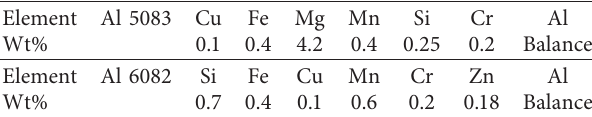
Table 1: Chemical composition of aluminum